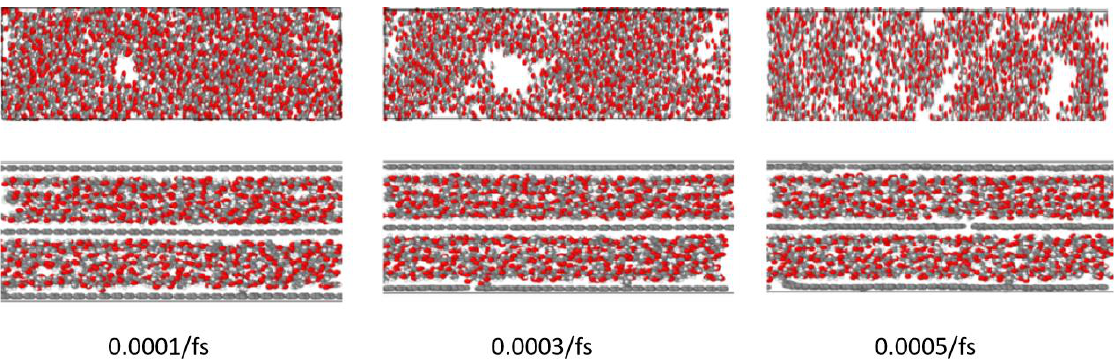
Figure 7. Visual representation of tensile process with different strain rates (Upper atomic model is pristine CNCs and the lower atomic model is CNCs-graphene layered composite).